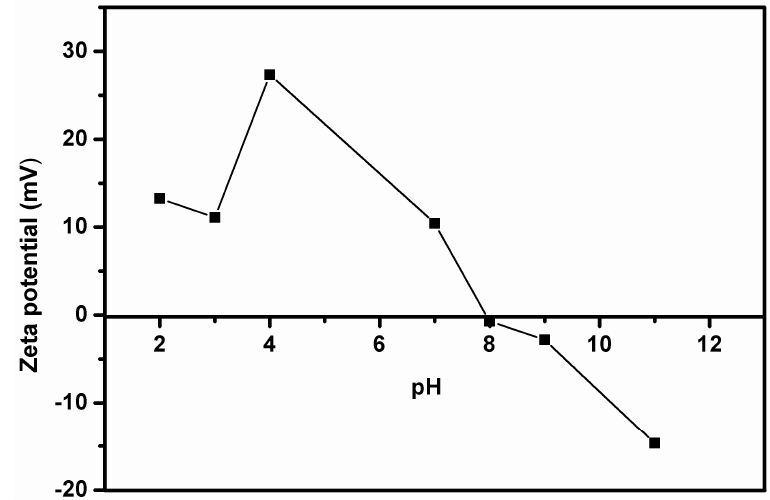
Figure 3. Determination of pHpzc of nanocomposite.